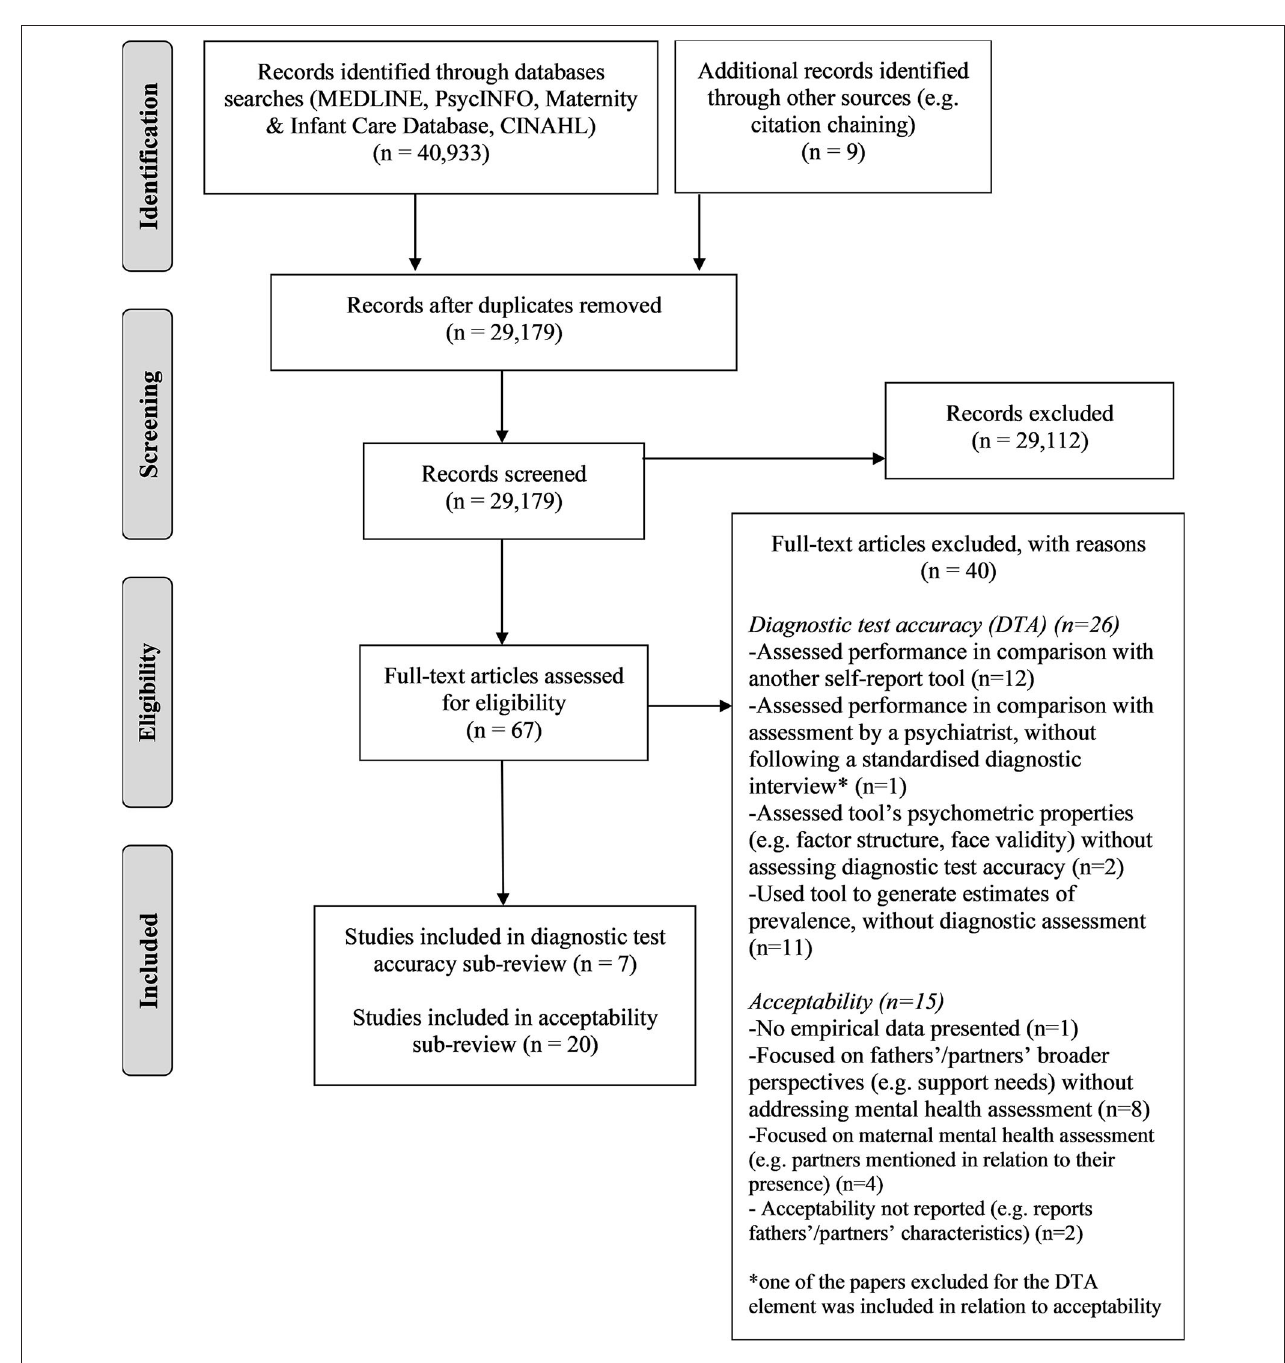
FIGURE 1 | PRISMA flowchart of review